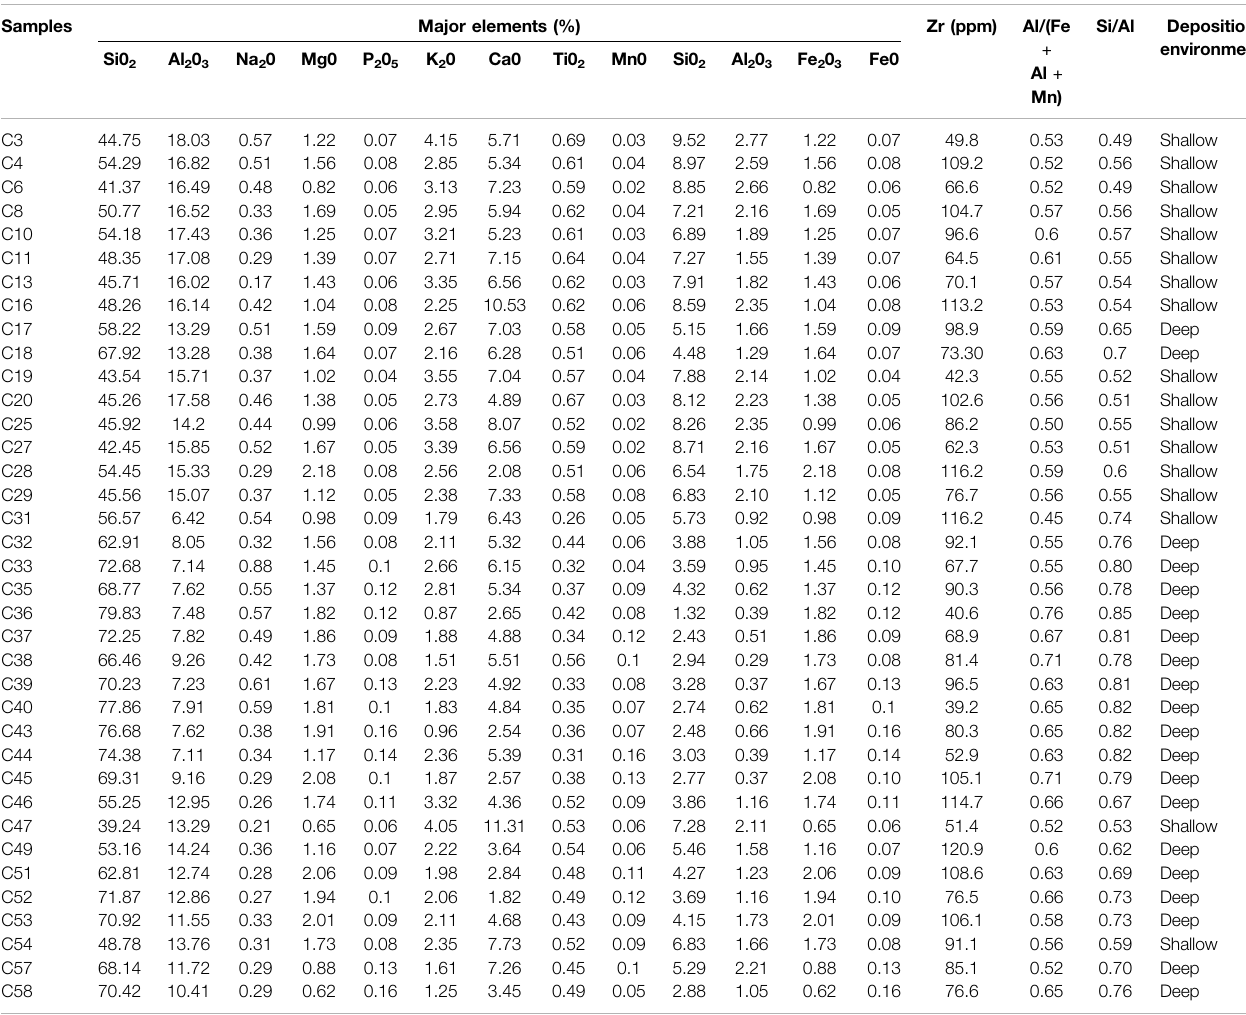
TABLE 2 | Whole rock major element analyses of shale samples.